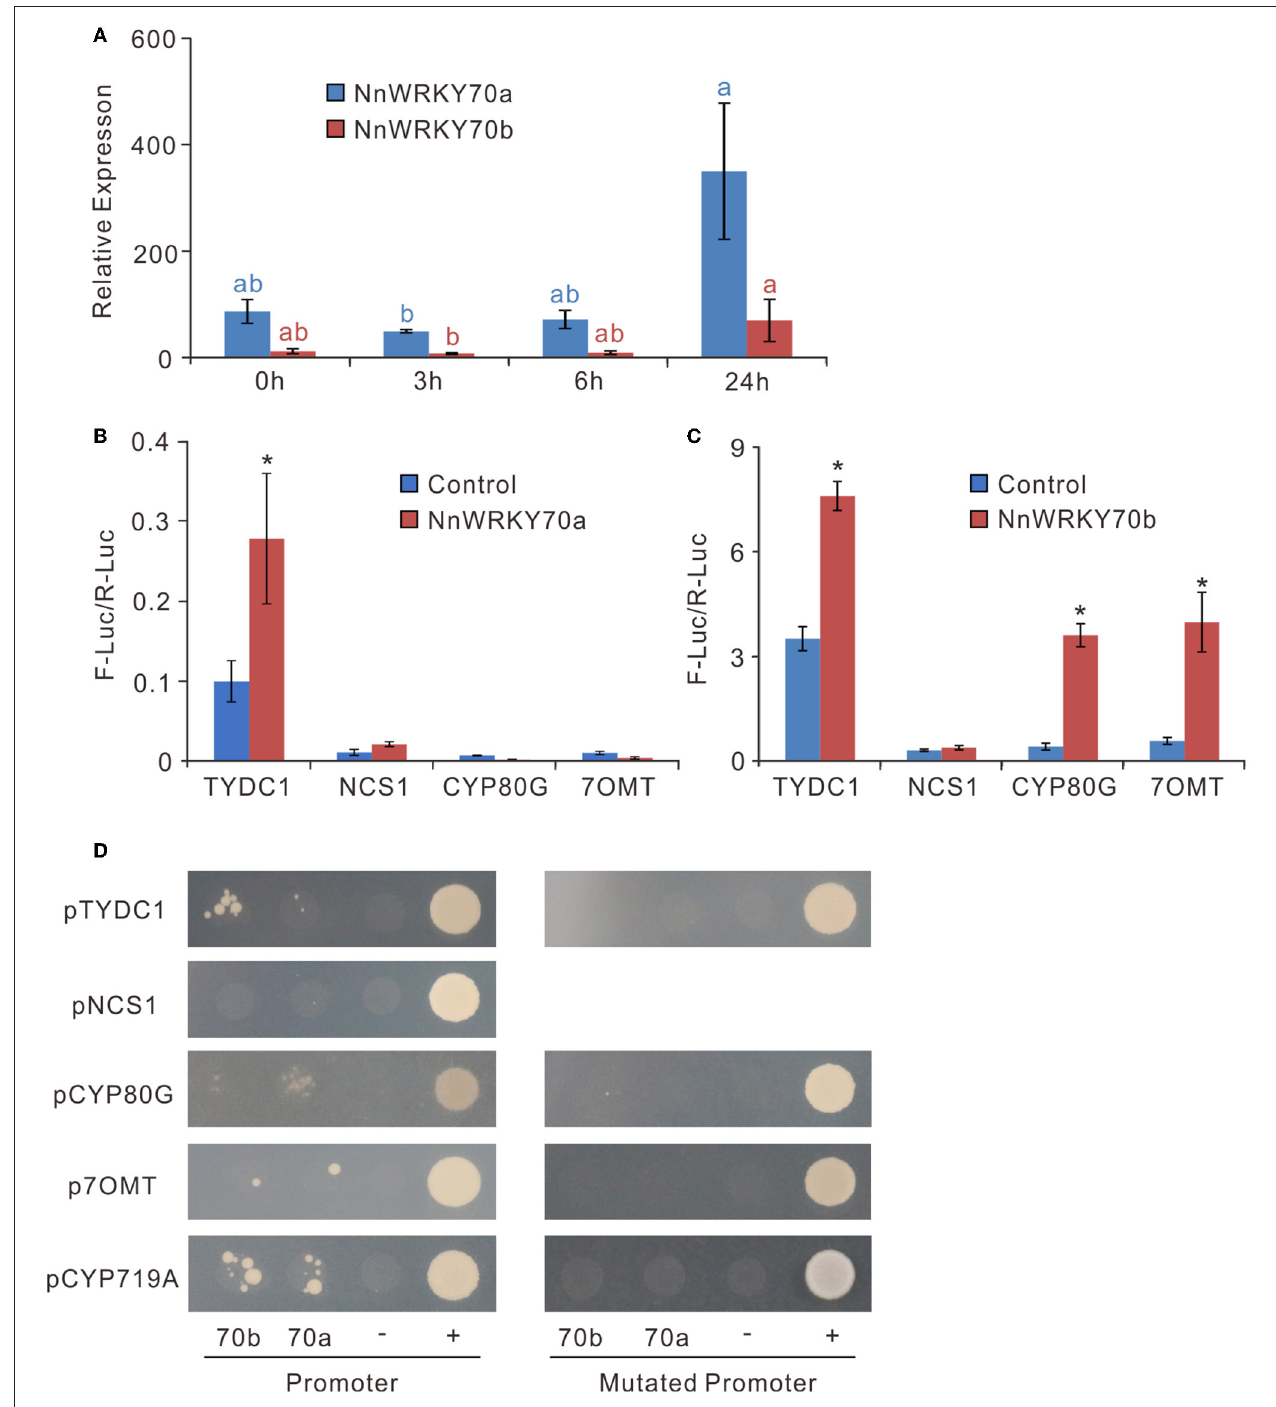
FIGURE 4 | NnWRKY70s are JA responsive and can activate the transcription of BIA biosynthetic genes. (A) Expression of NnWRKY70a and NnWRKY70b in lotus leaves in response to MeJA treatment. Lotus leaves were treated with MeJA at the developmental stage 4. (B,C) Dual-luciferase assays assessing the effect of NnWRKY70a and NnWRKY70b on activating the BIA pathway gene promoters. (D) Yeast one-hybrid assays checking the interactions between NnWRKY70a/NnWRKY70b transcription factors and BIA pathway gene promoters. Y1HGold bait strains transformed with pGADT7 prey vectors were cultured on SD/-Leu medium supplied with 100ng/mL AbA. “70b”, NnWRKY70b; “70a”, NnWRKY70a; “-”, negative control transformed with empty AD vector; “ + ”, positive control (p53-AbAi + AD-p53); Mutated promoters, BIA pathway gene promoters with W-boxes removed. Data of (A – C) are mean ± SE ( n = 3). Lower case letters and asterisks (*) represent significant differences at P <